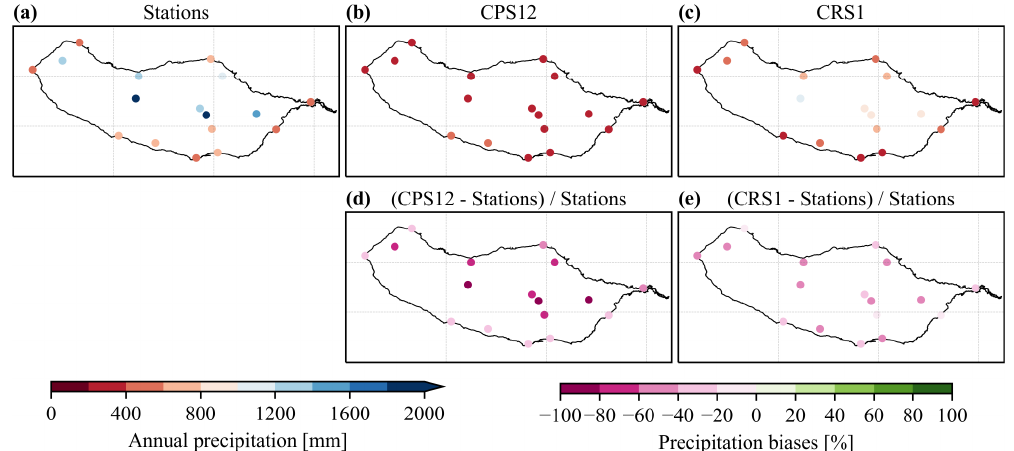
Figure C1. Annual precipitation [mm] over (a–c) the analysis region and (d–f) the Madeira Archipelago in (a, d) the ERA5 reanalysis, (b, e) CPS12 and (c, f) CRS1 from 2006 to 2015. Note the different scales for the top and bottom row panels. The geographic map is from Natural